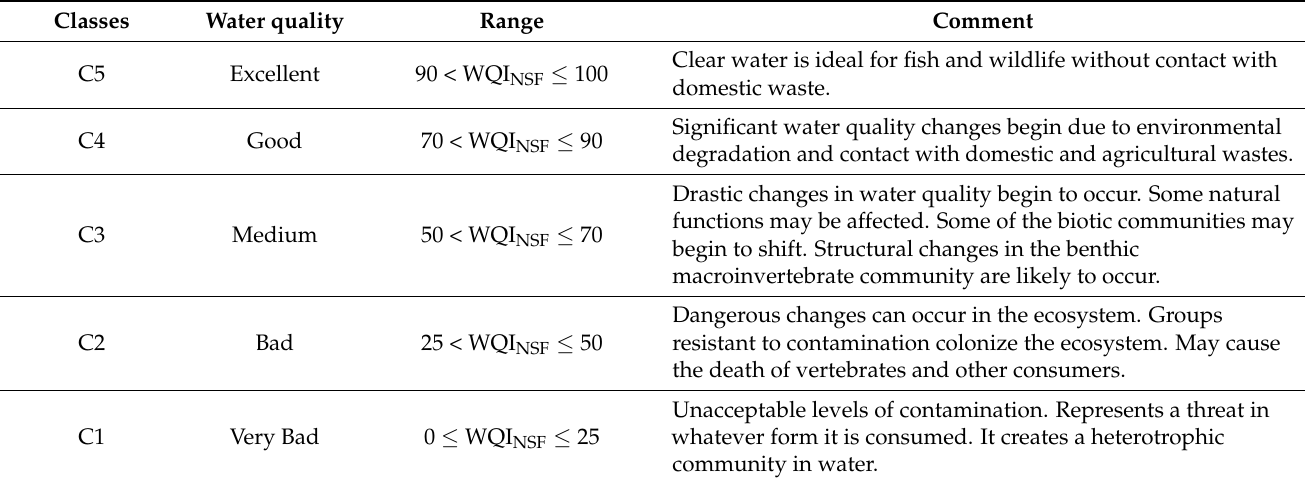
Table 3. Water quality classification regarding the WQI NSF values [10,28,29].